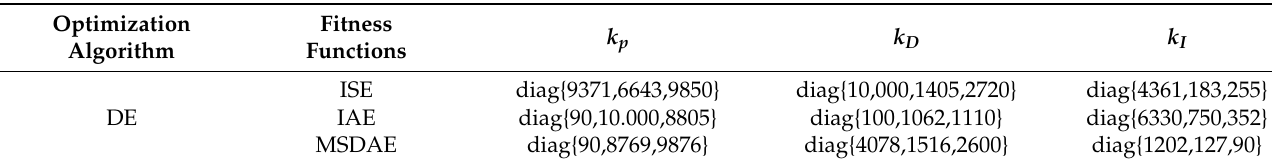
Table 5. Non-linear contour gain.